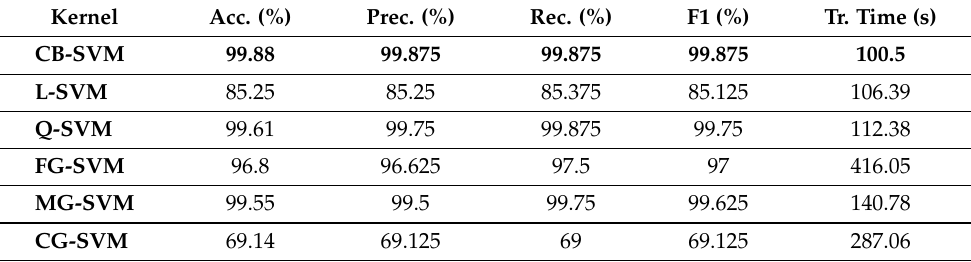
Table 3. Performance evaluation of classifiers used in the proposed model.